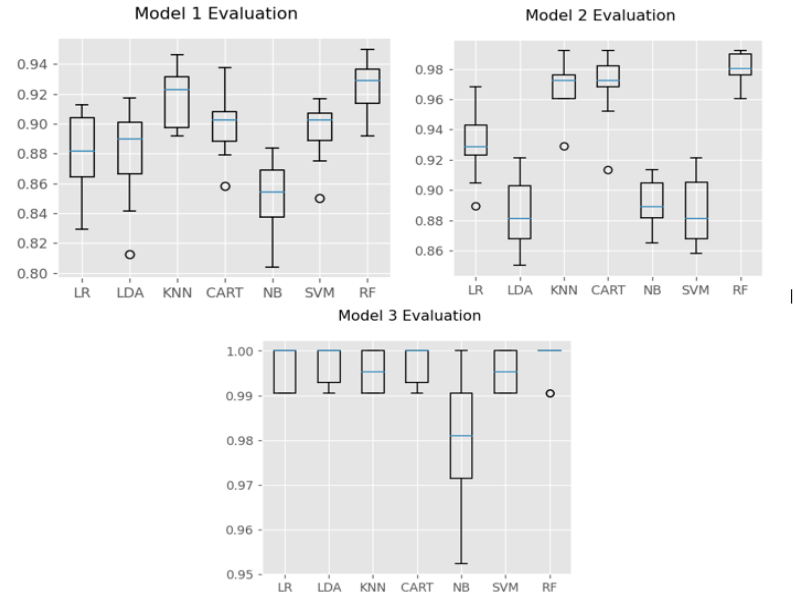
Figure 8. Chart of algorithm evaluation in the three models.